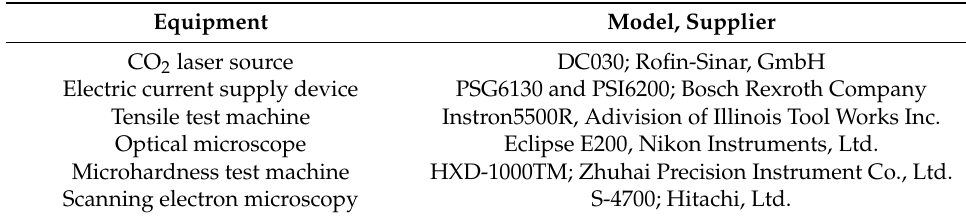
Table 2. Table 2. The experimental equipment used in this study. Table 2. The experimental equipment used in this